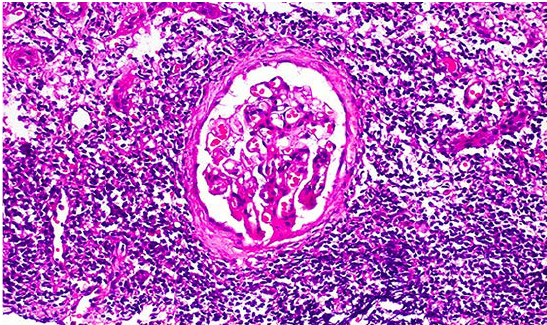
fIguRE 3 – At the center of the image, a glomerulus with pericapsular fibrous thickening can be seen. This glomerulus, however, does not show other histopathological changes, such as leukocyte infiltration, endocapillary hypercellularity and a hyperlobulated pattern. Note the presence of dense lymphomononuclear infiltrate in the interstitium. HE, 400X.